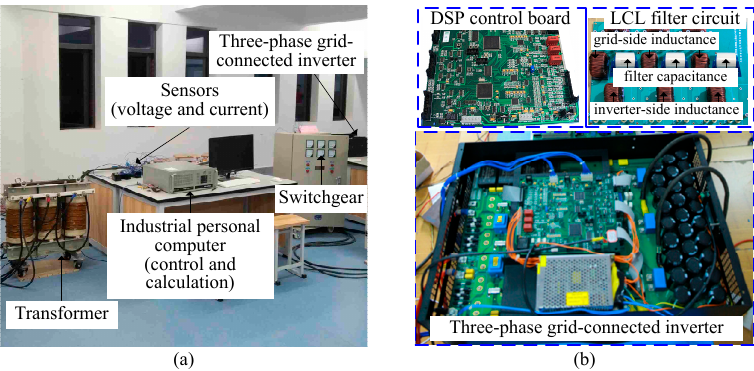
Figure 13. The Nyquist diagrams of the eigenfunction.